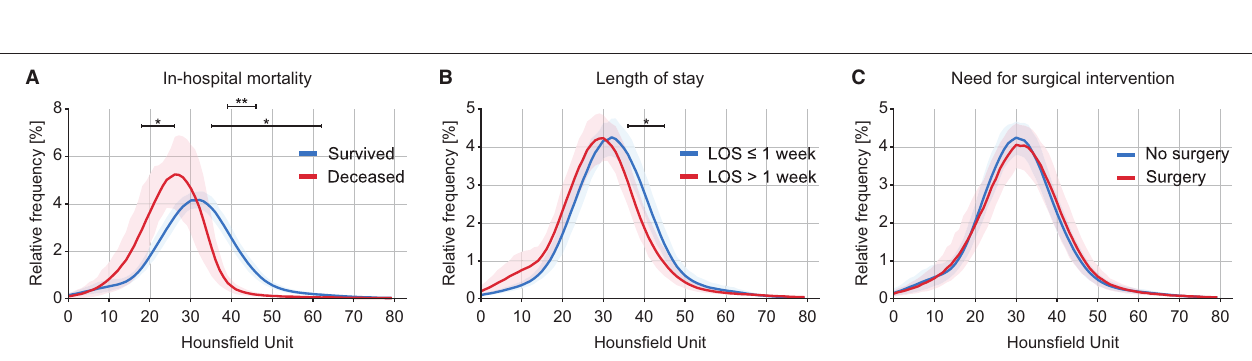
FIGURE 6 | Comparison of intracranial densitometry by alternative outcome measures: in-hospital mortality (A) , length of stay (B) and need for surgical intervention (C) . The bold line and shaded area denote the mean and range of the 95% confidence interval, respectively. Significance at p < 0.05* and p < 0.001**.